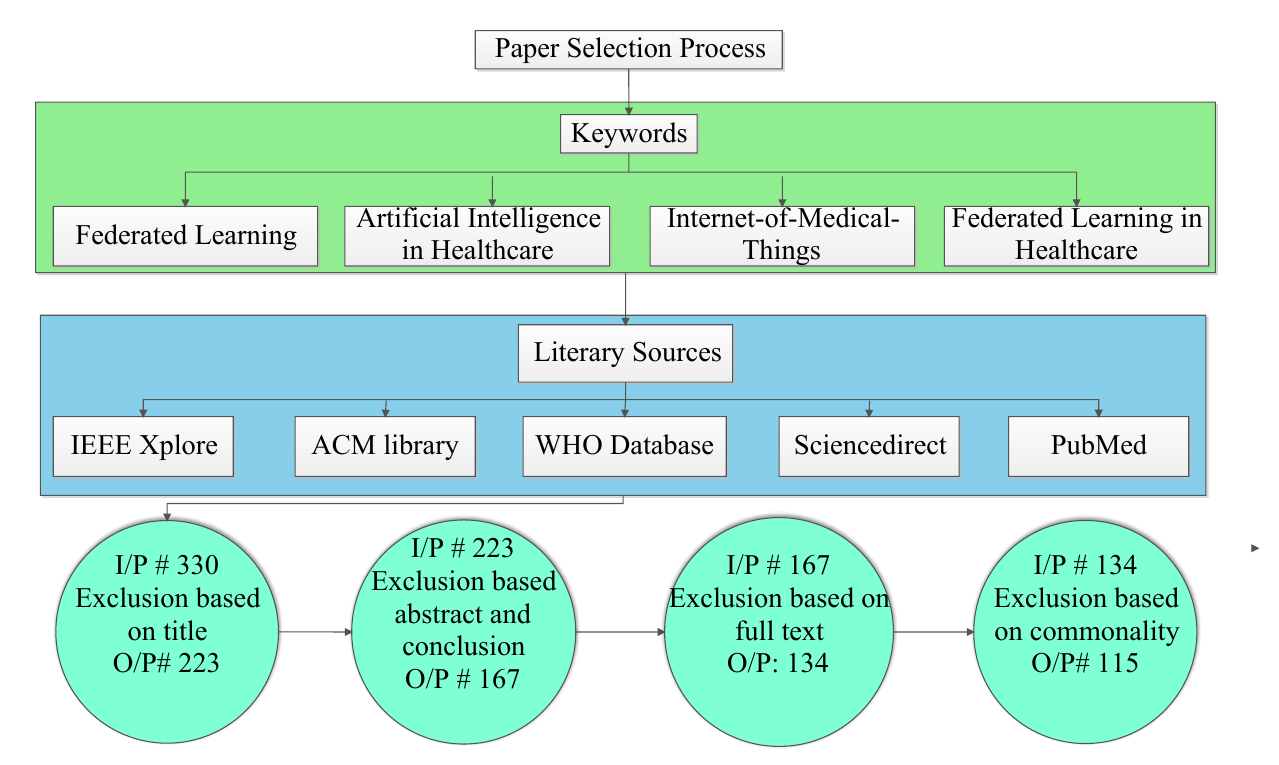
Figure 3. Survey methodology and